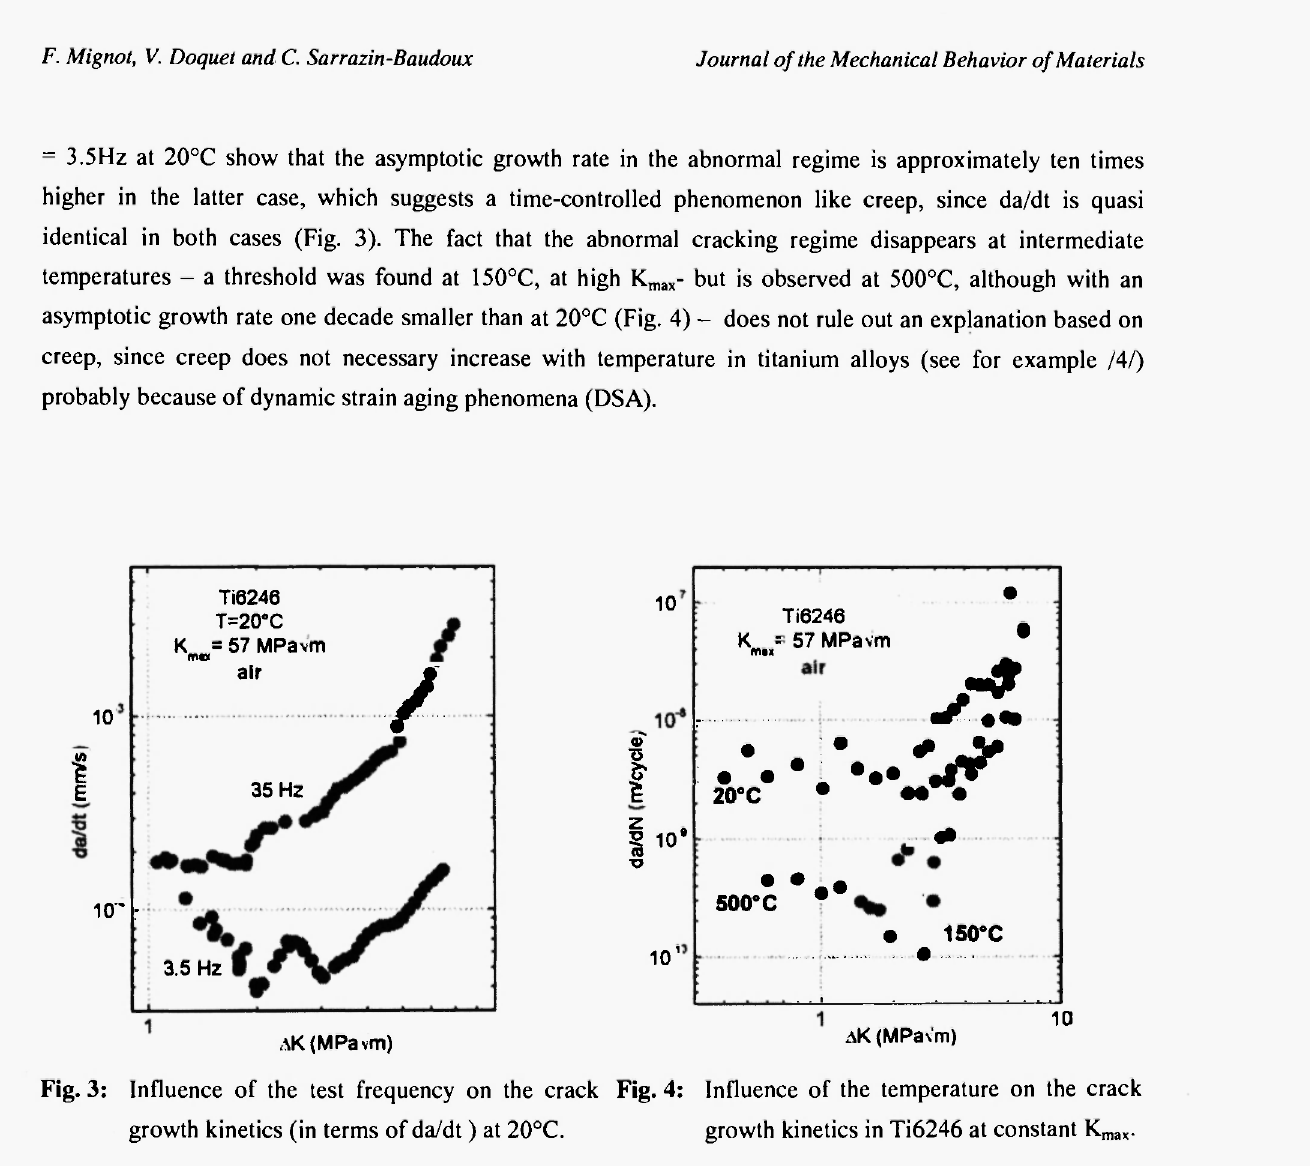
Fig. 3: Influence of the test frequency on the crack Fig. 4: Influence of the temperature on the crack growth kinetics (in terms of da/dt) at 20°C. growth kinetics in Ti6246 at constant K max